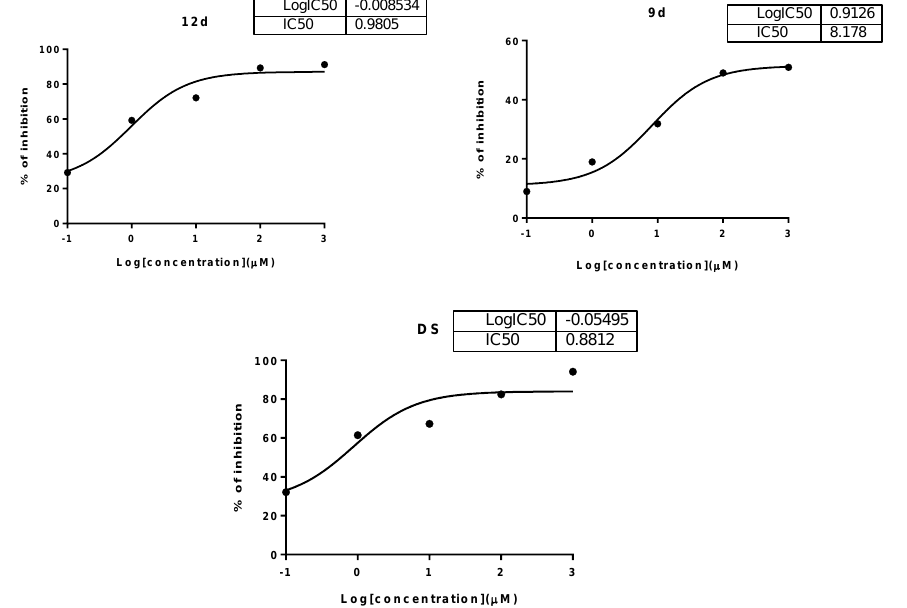
Figure 3. Dose-inhibition response calculation curve fit for calculation of the IC 50 [ µ M] of 12d , 9d and Diclofenac sodium (DS) values using GraphPad prism.